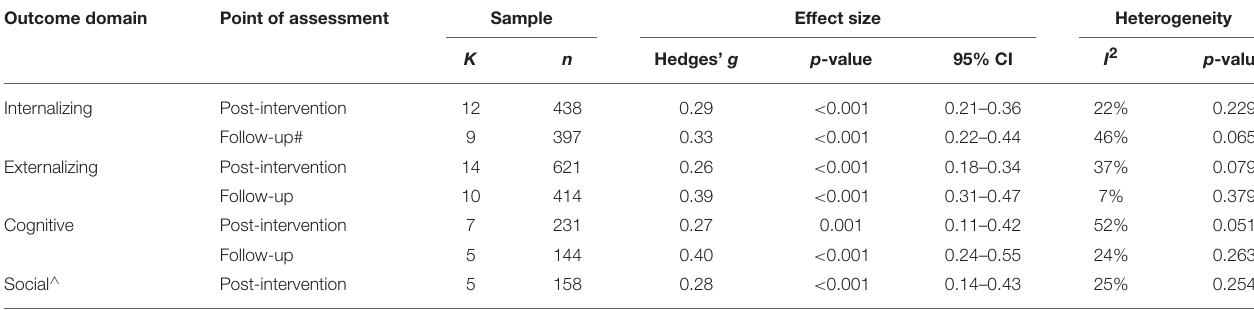
TABLE 4 | Within-group effects for four youth outcome domains.